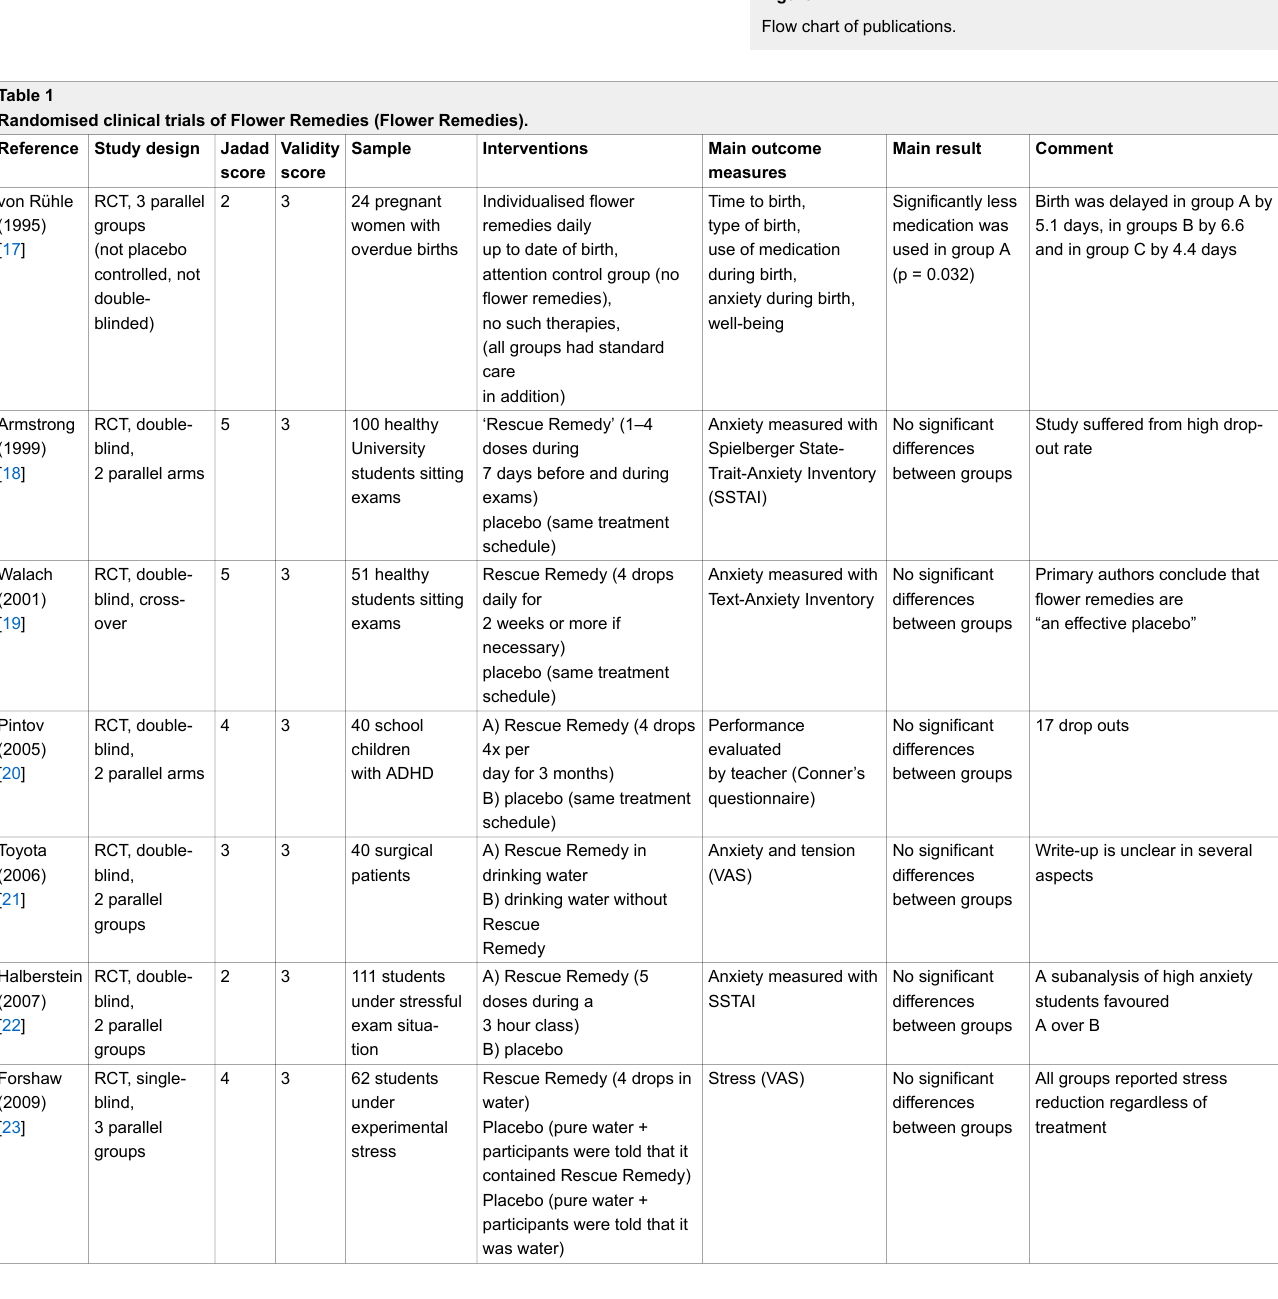
Flow chart of publications.